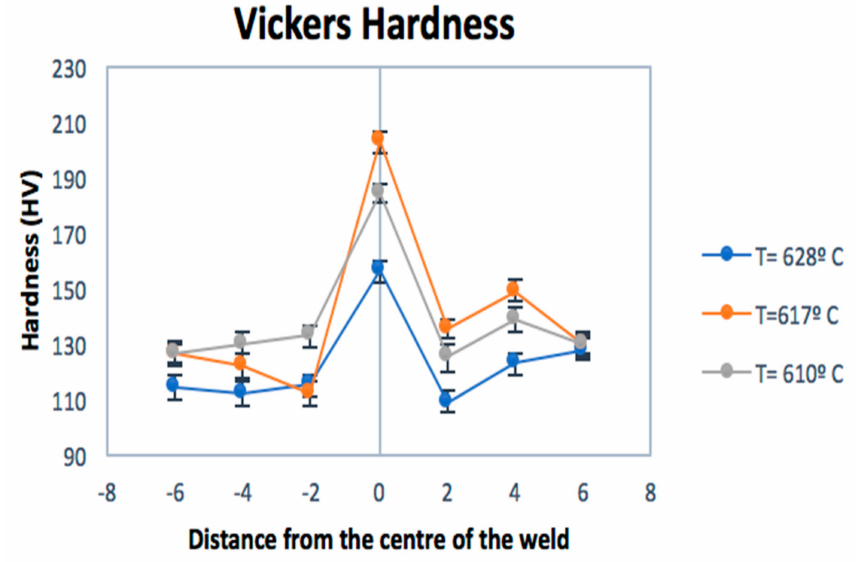
Figure 11. Graph of hardness versus position from the weld centre for Al 7075 alloy EB welded plates after heat treatment at three temperatures: 610, 617 and 628 ◦